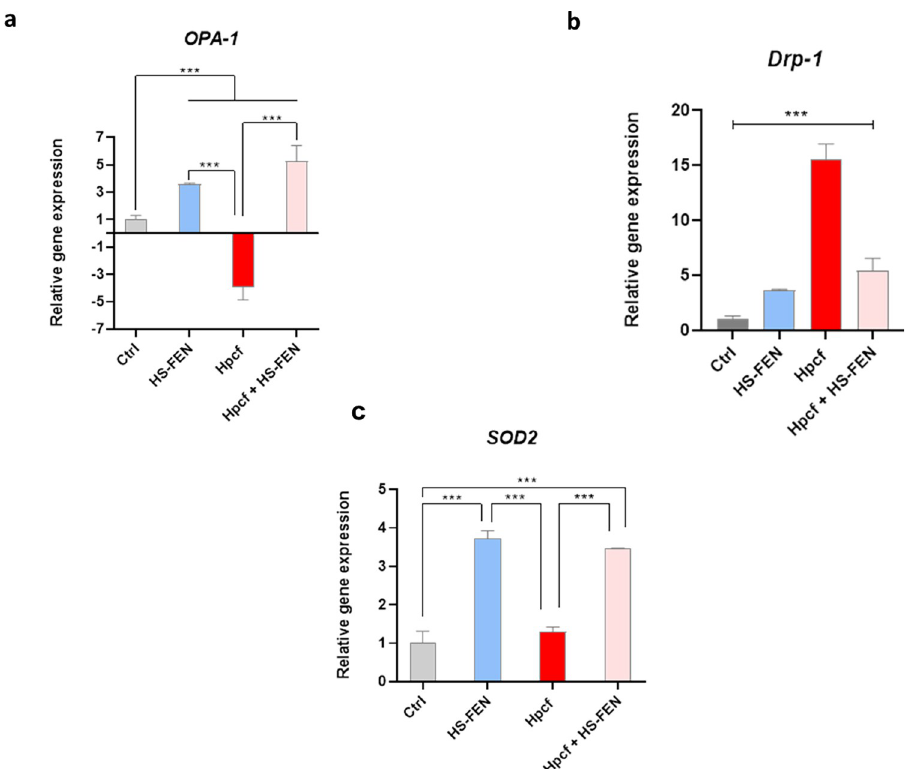
Fig 7. HS-FEN subverts detrimental effects elicited by Hpcf. Cellular expression of OPA-1 ( a ), Drp-1 ( b ) and SOD2 ( c ) genes detected by quantitative PCR performed on RNA extracted from AGS cells cultured for 3 hours with HS-FEN 25 μ g mL -1 in presence or absence of Hpcf (1:2) stimulation. GAPDH was used as housekeeping gene to normalize all samples. Data were represented as means ± s.d. of three independent experiments, each performed in triplicate. One- way ANOVA followed by Bonferroni post hoc correction was used to determinate statistically significant differences ( ��� p < 0.0001).